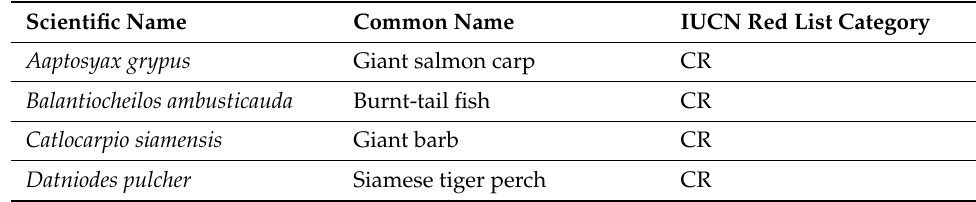
Table 2. Twenty-five threatened fishes of the Cambodian Mekong. CR = Critically Endangered; EN = Endangered; VU = Vulnerable. While Cambodia supports both high fish diversity and high fisheries productivity, overfishing and illegal harvest, habitat degradation and fragmentation, and changes to hydrology and climate pose significant risk to species